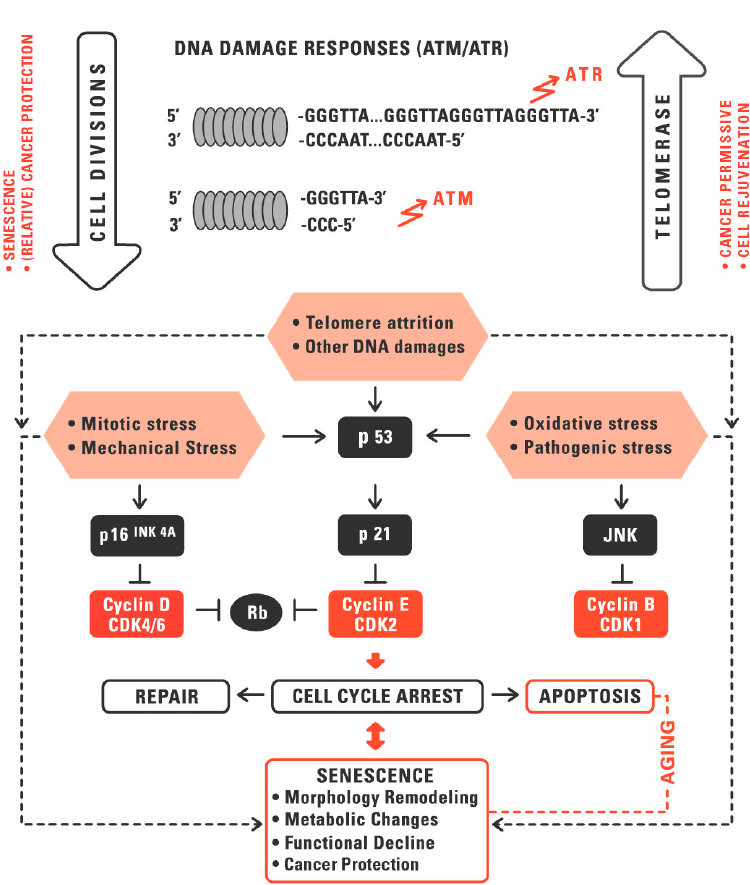
Figure 1. Replicative aging cooperates with other aging mechanisms to activate the p53 and/or Rb Rb signaling pathways. ATM and ATR are sensors of DNA double- and single-strand signaling pathways. ATM and ATR are sensors of DNA double ‐ and single ‐ strand damage induced by replicative senescence or other DNA damage. Activated ATM and ATR trigger checkpoint responses to induce cell cycle arrest. A stronger stimulation of p53 may lead to apoptosis by activating